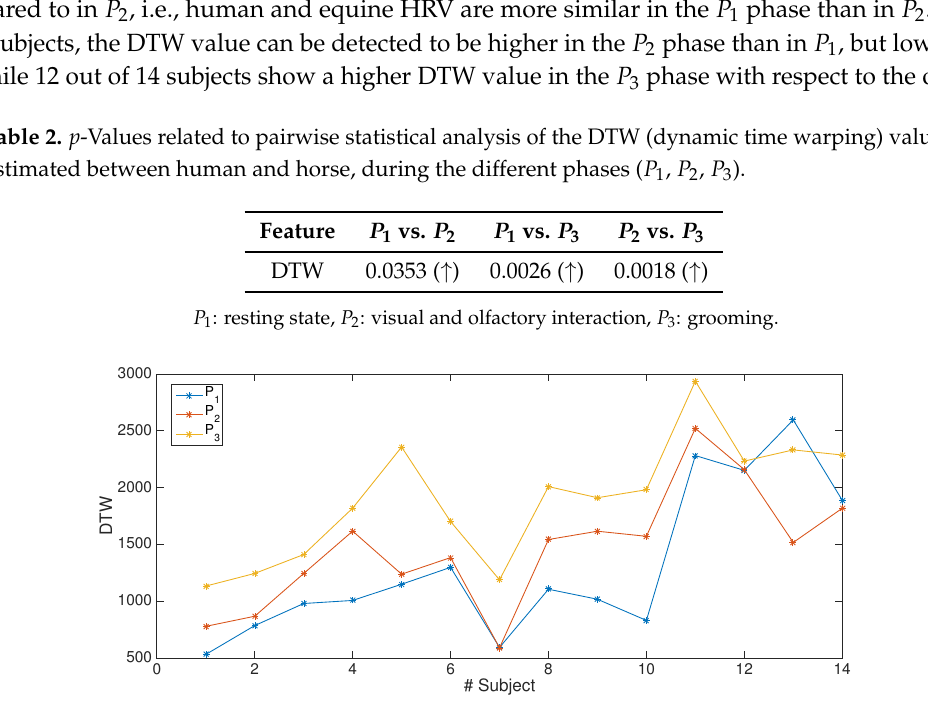
Figure 5. DTW (dynamic time warping) values, as estimated between human and horse, obtained for each subject in each